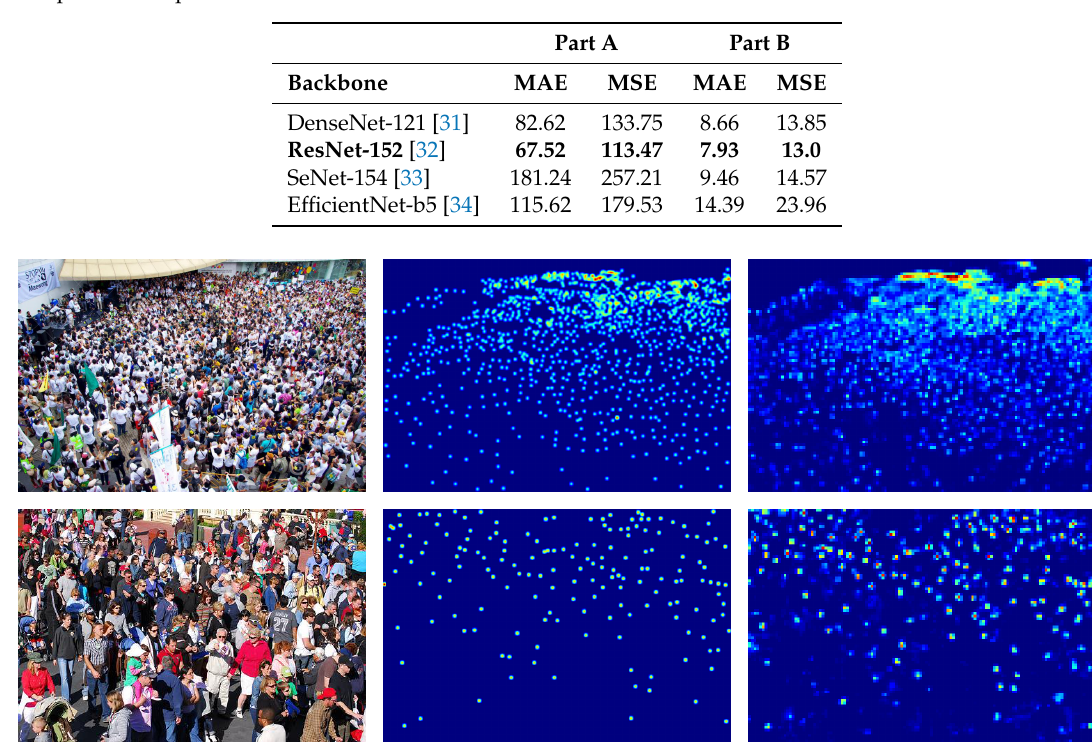
Figure 7. ShanghaiTech part A density map estimation examples. Left the crowd image, middle ground-truth density map, right estimated density